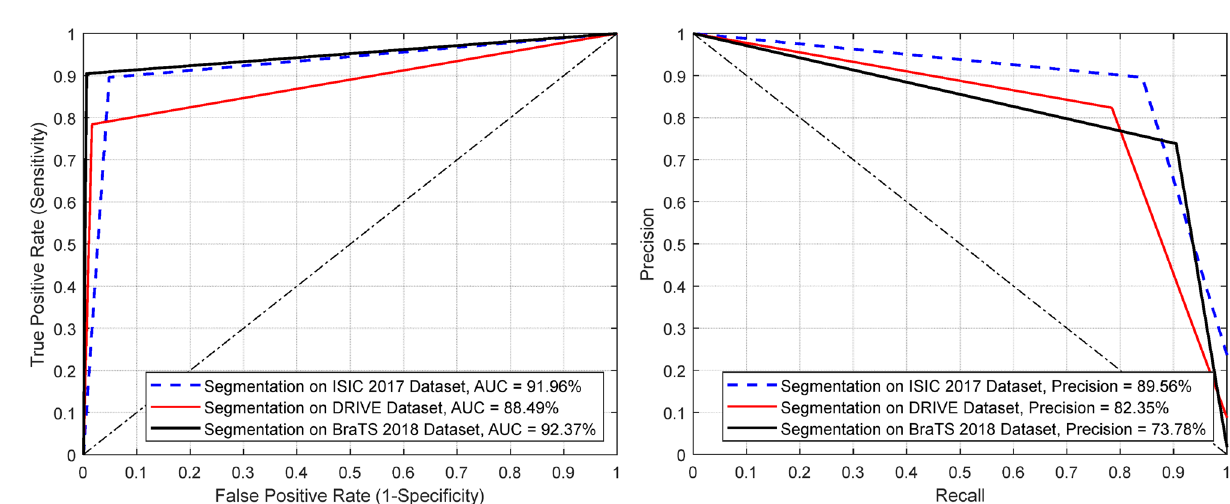
Figure 8. ROC curves (left) and PR curves (right) of our proposed CMM-Net segmentation method on three different medical